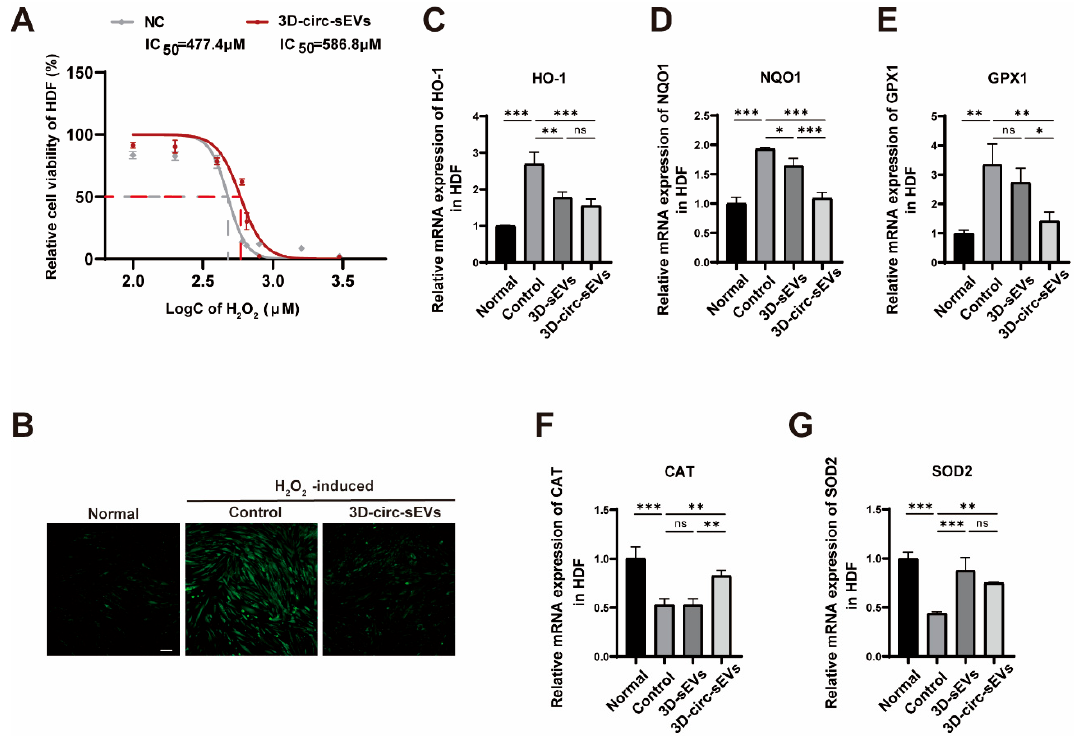
Figure 5. 3D-circ-sEVs have a slight preventive effect on oxidative stress induced by H 2 O 2 in vitro. ( A ) Relative cell viability of HDF treated with or without 3D-circ-sEVs tested by CCK-8. ( B ) Repre- sentative images showed the level of ROS in HDF cells treated with or without 3D-circ-sEVs. Scale bar: 100 μΜ . ( C – G ) qRT-PCR analysis of the effect of 3D-circ-sEVs on the mRNA expression of HO-1, NQO1, GPX1, CAT, and SOD2 in H 2 O 2 -induced oxidative stress HDF cells (n = 3). One-way ANOVA and Tukey post hoc test analyses were performed. ns represents not significant. Error bar, mean ± SD. * p ≤ 0.05; ** p ≤ 0.01; *** p ≤ 0.001.